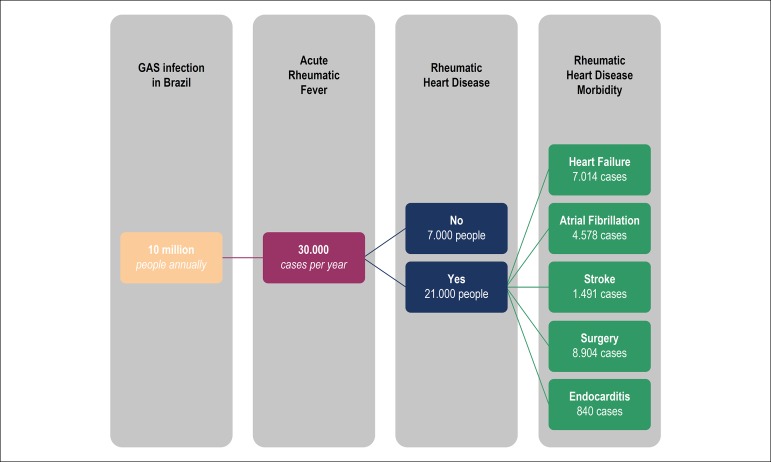
GAS: Group A β-hemolytic Streptococcus. Hypothetical scenario
based on the current panorama of rheumatic fever in Brazil, after
crossing data from the Brazilian Institute of Geography and Statistics
with data from the REMEDY study,16 showing the evolution of Acute
Rheumatic Fever to Rheumatic Heart Disease, with their respective
morbidities in numbers.